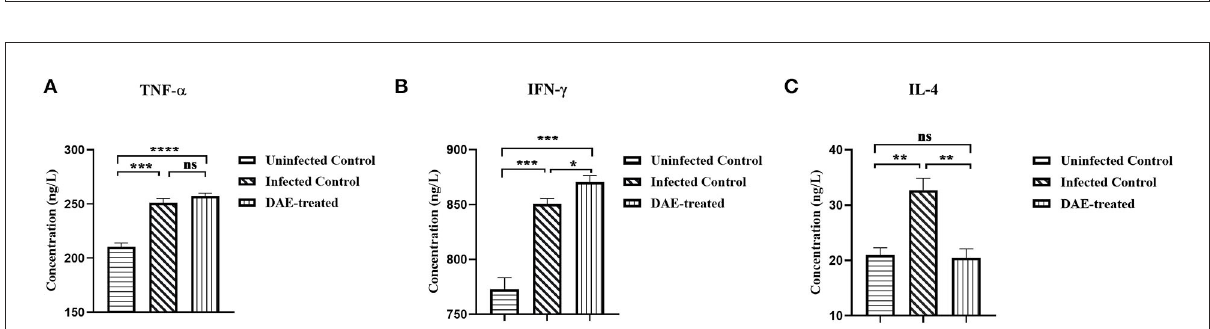
FIGURE6 The concentrations of TNF- α (A) , IFN- γ (B) , and IL-4 (C) in serum obtained from test mice. At 76h post-PRV infection, three mice from each group were randomly selected for the collection of blood, which was used to determine the levels of three cytokines in mouse serum (**** P < 0.0001, *** P < 0.001, ** P < 0.01, * P < 0.05, ns: P >